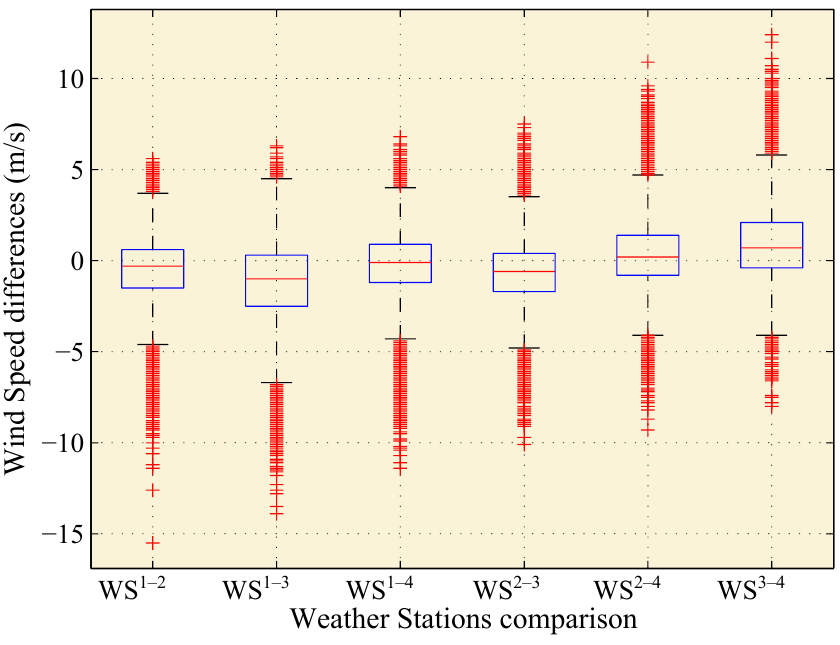
Figure 7. Box plots of wind speed differences between weather stations. In Figure 8, it is clear that there are more differences between ambient temperatures of WS 1 and the others. So, it can be said that WS 1 obtains lower ambient temperature values than the others. Other stations apart from WS 1 have a less pronounced variability.